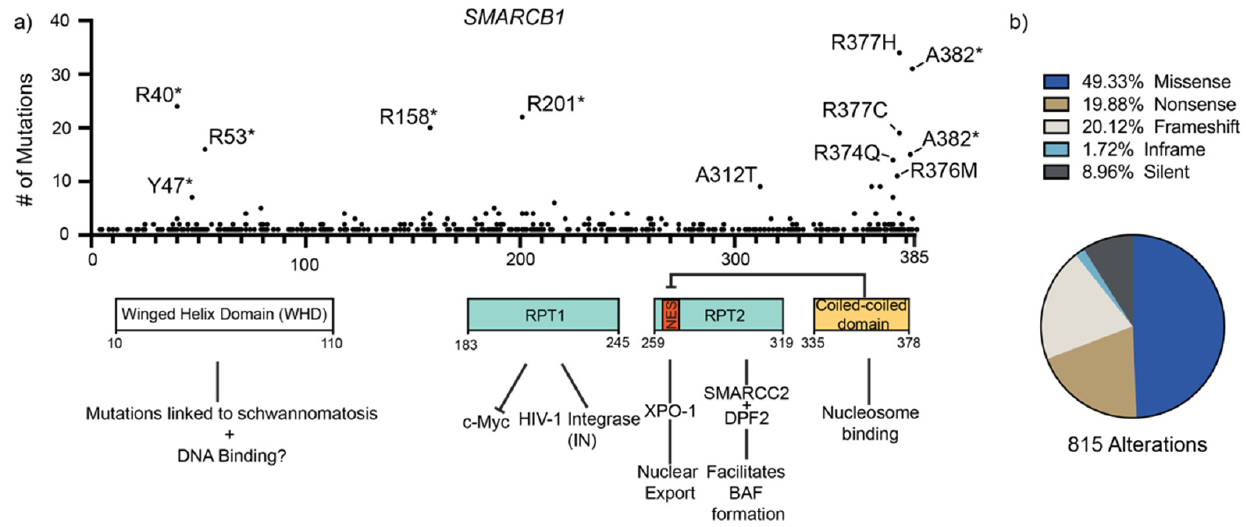
Figure 1. Cancer-associated mutations and molecular interactions of SMARCB1. Data obtained from COSMIC (v95) reveal a clustering of mutations in the C-terminal coiled-coiled domain as well as a high preponderance of truncation mutations on the N-terminal end. ( a ) Frequency of cancer associated mutations in SMARCB1 . Nonsense mutations and frameshift mutations are denoted by (*). The four known functional domains of SMARCB1 and their reported molecular interactions are shown. ( b ) The proportion of each mutation type within the COSMIC dataset. In-frame and frameshift mutations include both deletions and